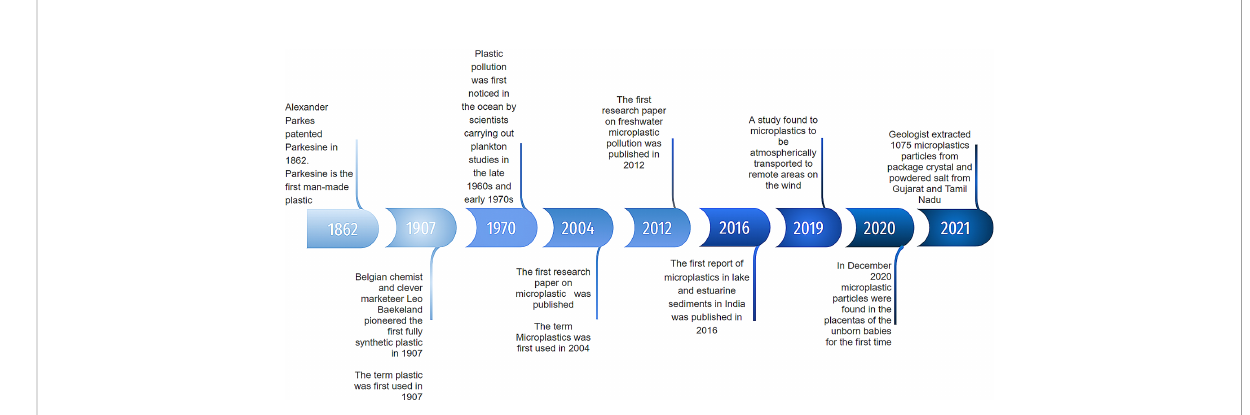
FIGURE 1 Flowsheet shows the milestones in evolution of plastic to microplastic over the